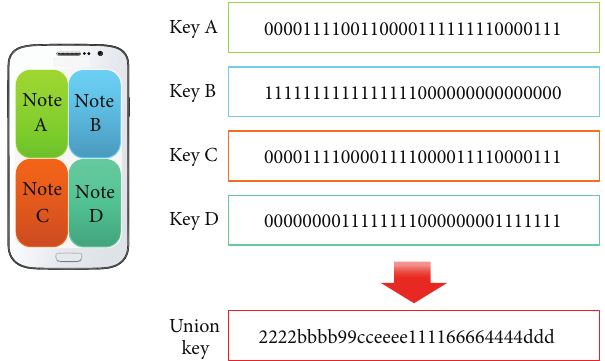
Figure 2: Generation of a union key using a single track for each